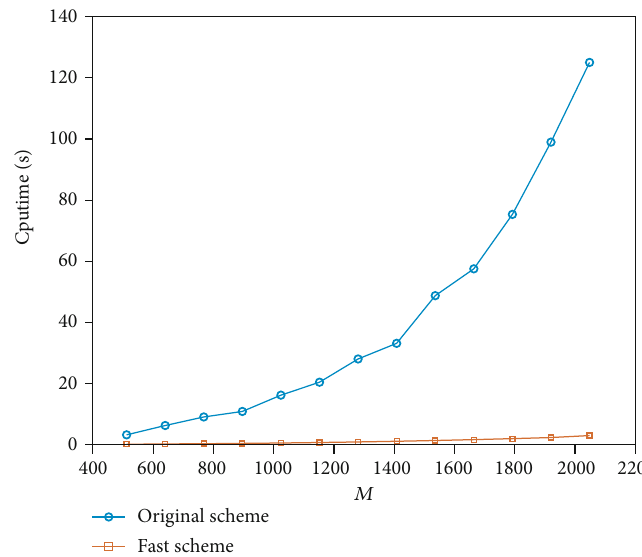
Figure 1: Comparison of CPU execution time between original and fast schemes with fi xed α = 0 : 3 and β = 0 : 8 :